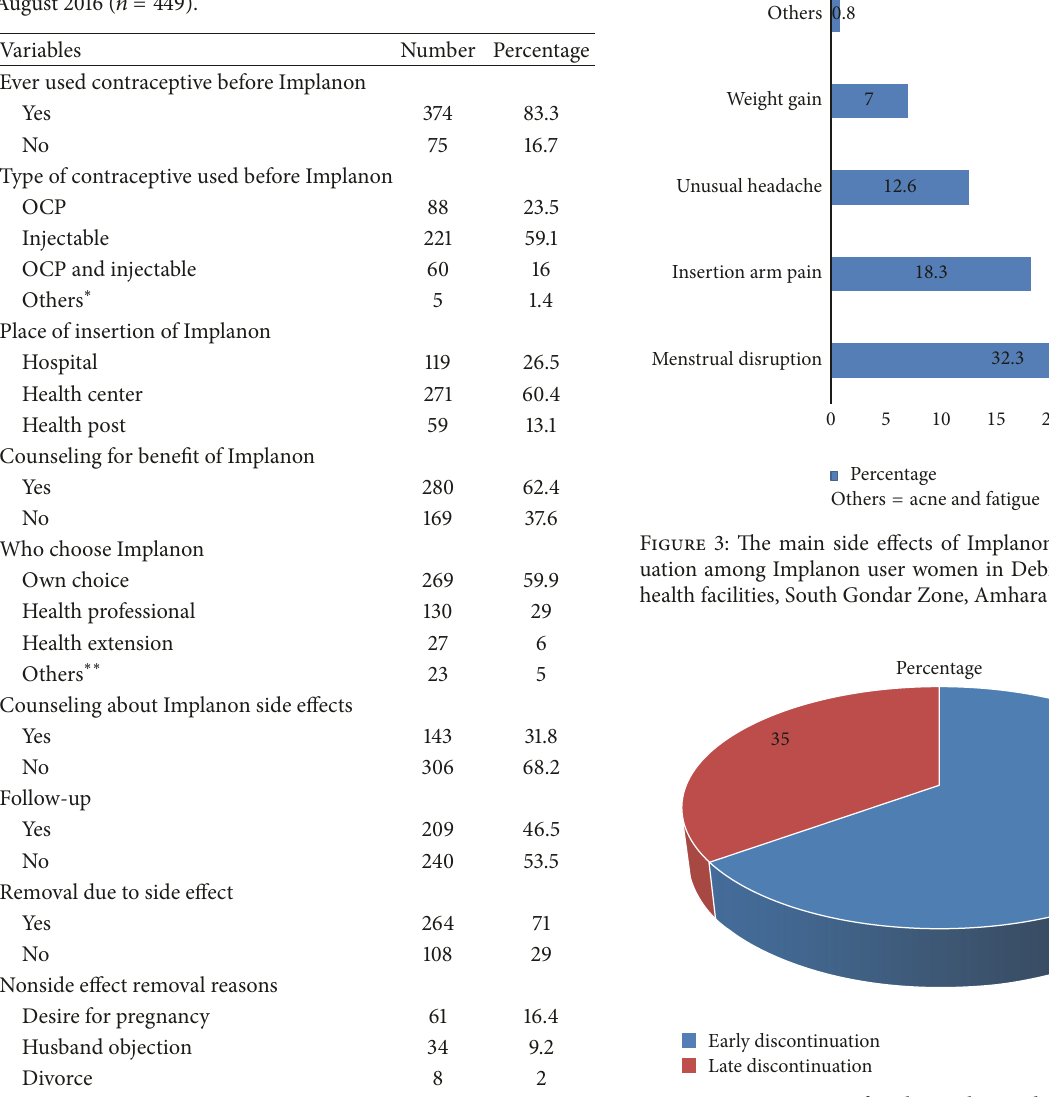
Figure 4: Proportion of early Implanon discontinuation among Implanon user women in Debre Tabor town public health facilities, South Gondar Zone, Amhara Region,